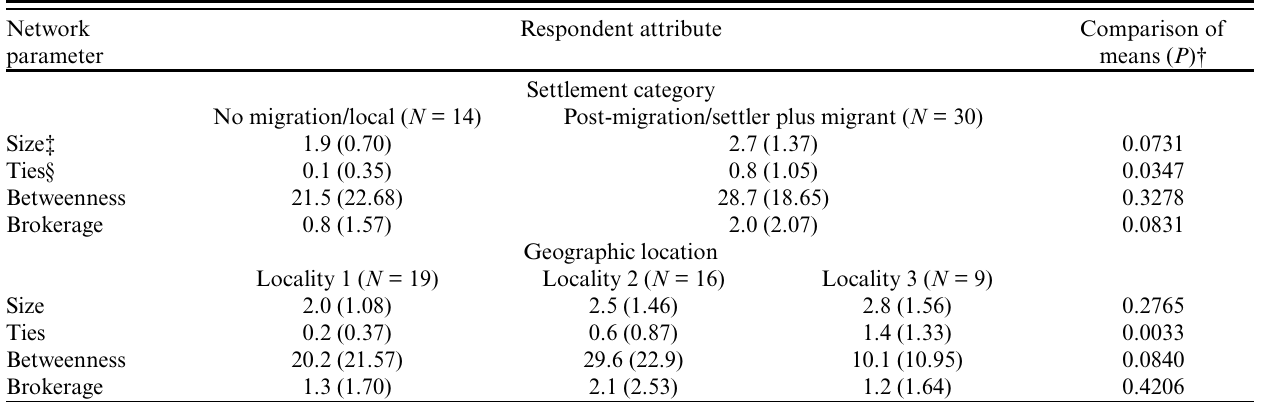
Table 2. Mean (SD) value of individual network parameters across settlement category and geographic location for the study area, Sunyani District, Brong Ahafo Region, Ghana.